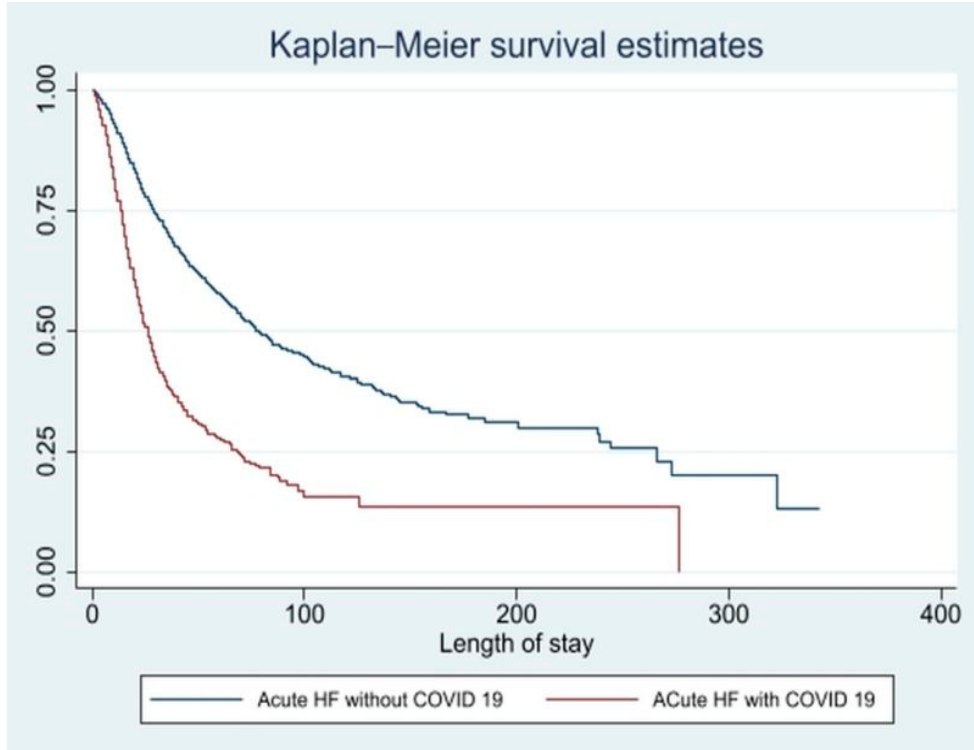
Figure 1. Kaplan–Meier survival analysis of mortality and length of stay.